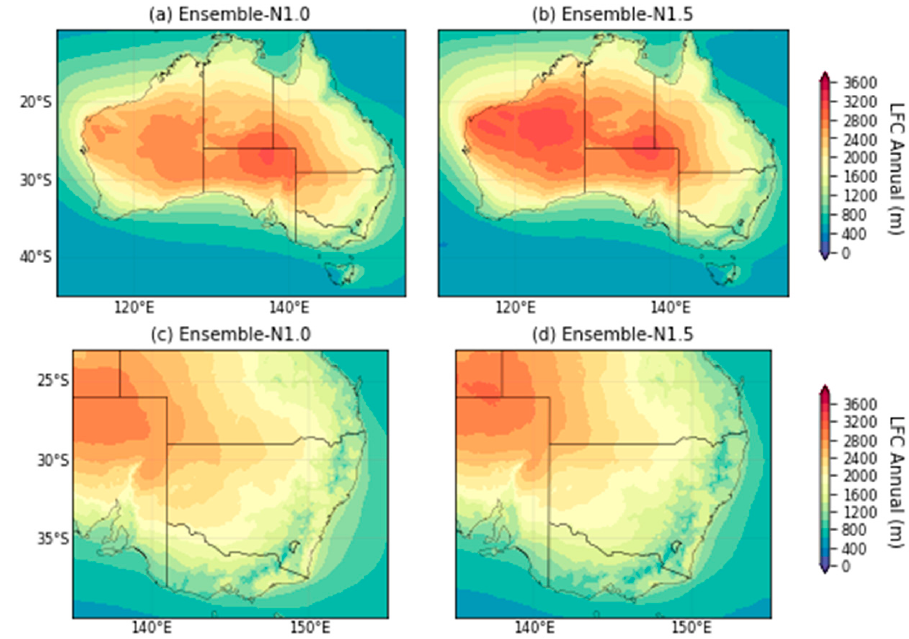
Figure A2. As in Figure A1 except for LFC.